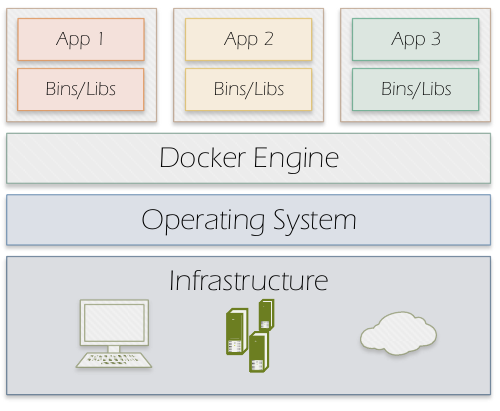
Figure 2. Docker